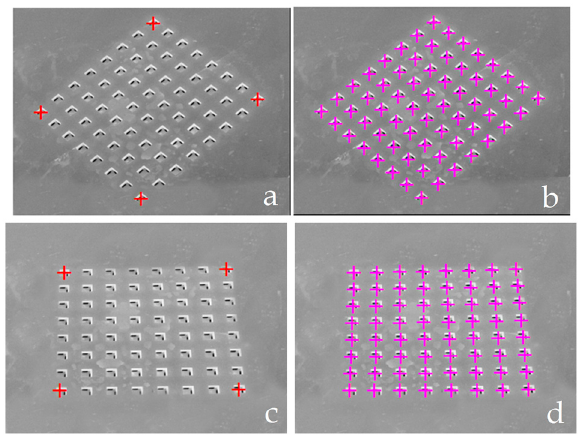
Figure 14. Two different angle views of the smart surface, captured for two different angled embedded camera placements. The extreme holes are presented by red color “+” symbols ( a , c ) and others holes are presented by violet color “+” symbols ( b , d ).